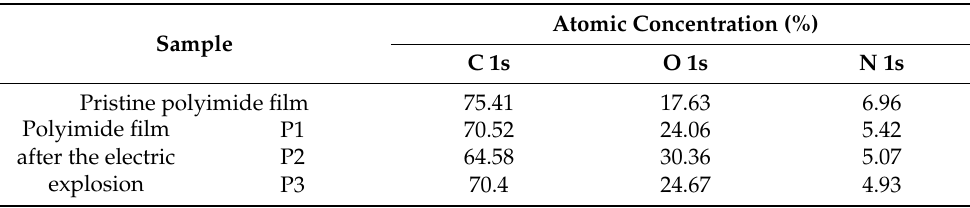
Table 3. The atomic ratio of C, O, and N in pristine polyimide and the sample after the electric explosion test.